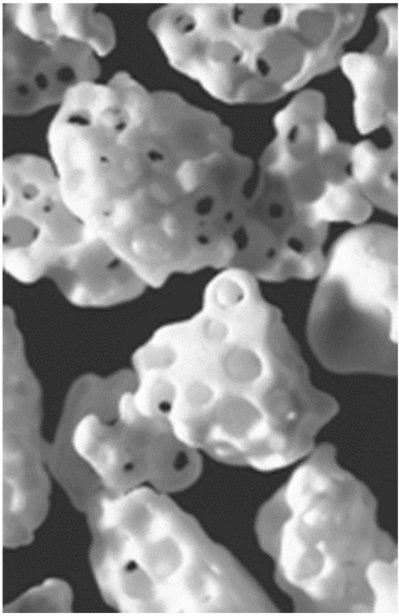
Figure 11. Rounded β -TCP granules 2.6–4.8 mm in size, providing no sharp edges for combination with bone cement. Reprinted from Ref. [595] with